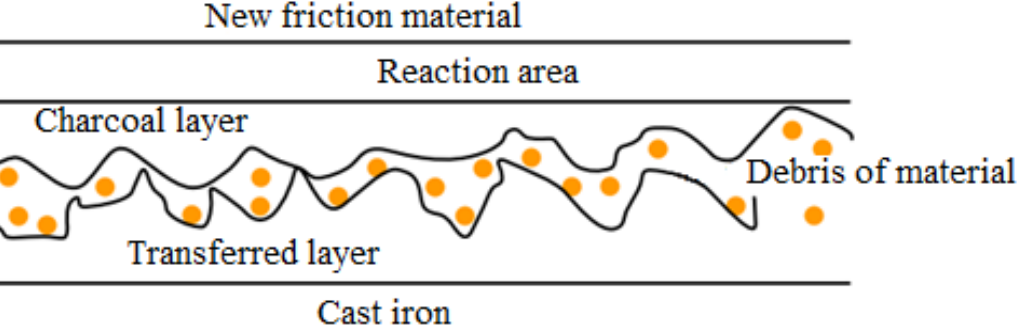
Figure 7. Model of a braking friction couple “five-phase” (cast iron disk and composite friction material), which includes a bond with resin (reprinted/adapted with permission from ref. [13]. 2022, Elsevier).